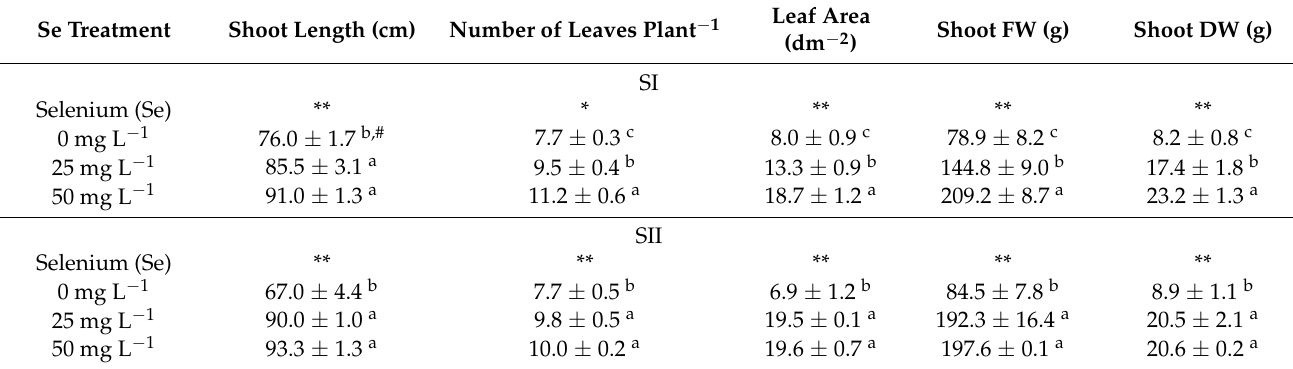
Table 3. Effects of foliar applications with Selenium (Se) on vegetative growth characteristics of onion under saline soil (EC = 5.2 dS m − 1 ) condition in 2016/17 (SI) and 2017/18 (SII) seasons. Se